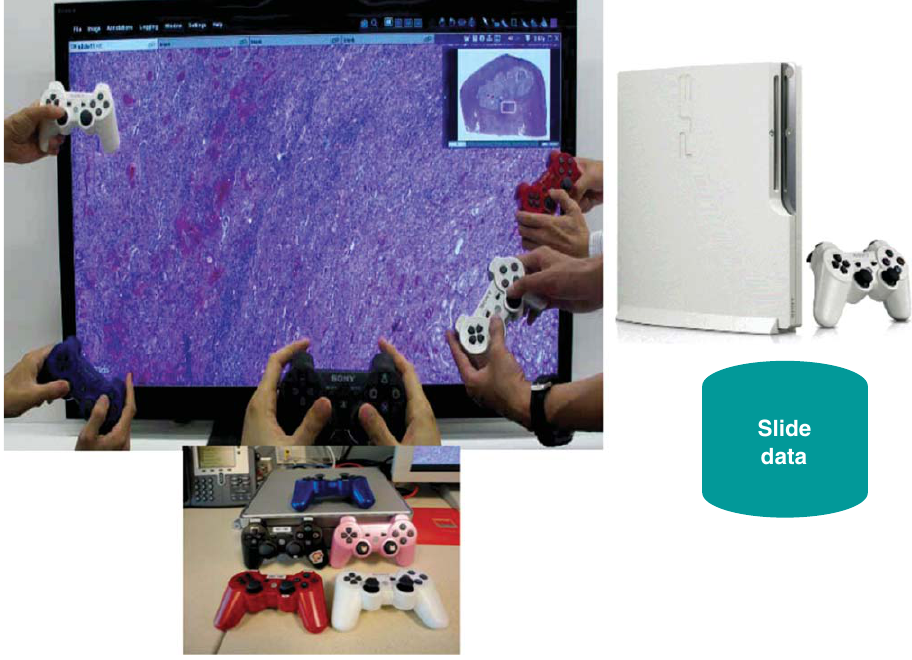
Fig. 5. The prototype WSI viewing system based on PS3 ® ; Standalone. Multiple wireless controllers can be used at the same time. The color of the pointer and controller are matched. Personalized controllers are useful. Every participant can use a pointer at anytime. However, only one person at a time can navigate images and control the magnification and location of the region of interest. This role can be easily switched to another participant who knows this because the controller will then